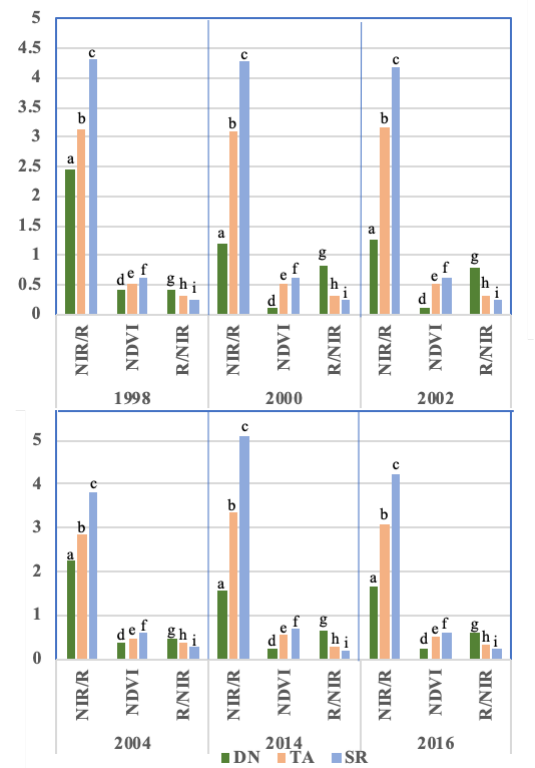
Figure 1. Average values of the Vegetation Index (NIR/R), Normalized Difference Vegetation Index (NDVI), and Simple Ratio Index (R/NIR) for predominately mixed conifer at three pre-processing levels (DN, TA, SR) across six years. Letters denote significant difference (p<0.001) between pre-processing levels within a given index. Average index values for pre- processing levels were not compared across different